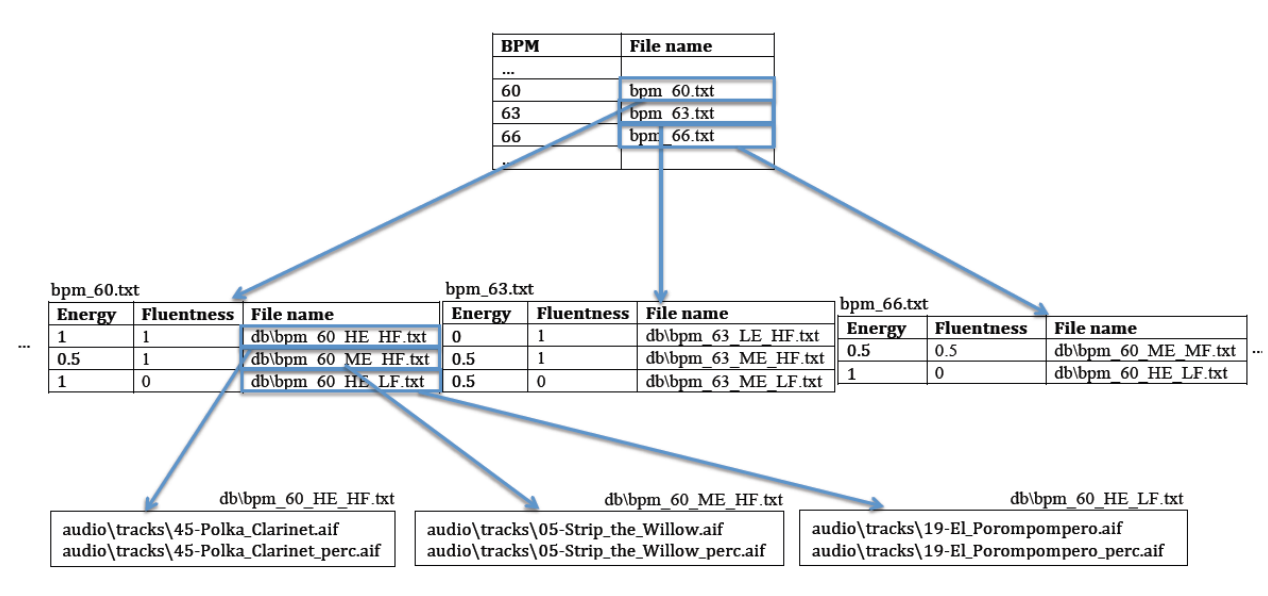
Figure 4. The tree structure for the metadata of the music database. At the root level, each tempo (measured in bpm) is associated with a file including annotations for energy and fluentness. Each combination of those is linked to a leaf including the list of music pieces exhibiting such combination of characteristics. This structure enables retrieving the result of a query by performing a visit of the tree in constant time, i.e., always requiring three steps. The files do not contain all the possible bpm values and all the possible combinations of energy and fluentness levels, but only those for which a song is available in the